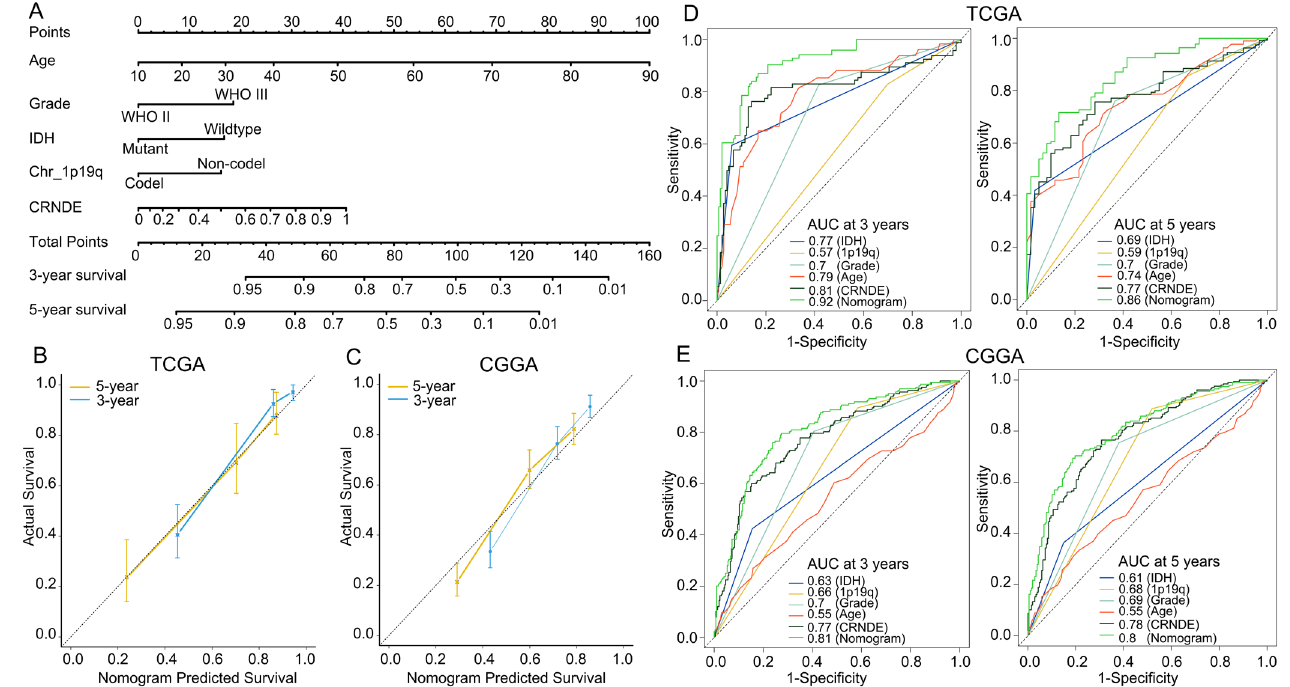
Figure 5. Nomogram model and its prediction performance. ( A ) Nomogram to predict the 3- and 5-year OS of LGG patients. ( B,C ) Calibration curves of the nomogram for predicting the 3- and 5-year OS in the ( B ) training and ( C ) external-validation sets. ( D,E ) Time-dependent ROC curves based on IDH mutation, 1p19q codeletion, tumor grade, patient’s age, CRNDE expression, and nomogram points in the ( D ) training and ( E ) external-validation sets.